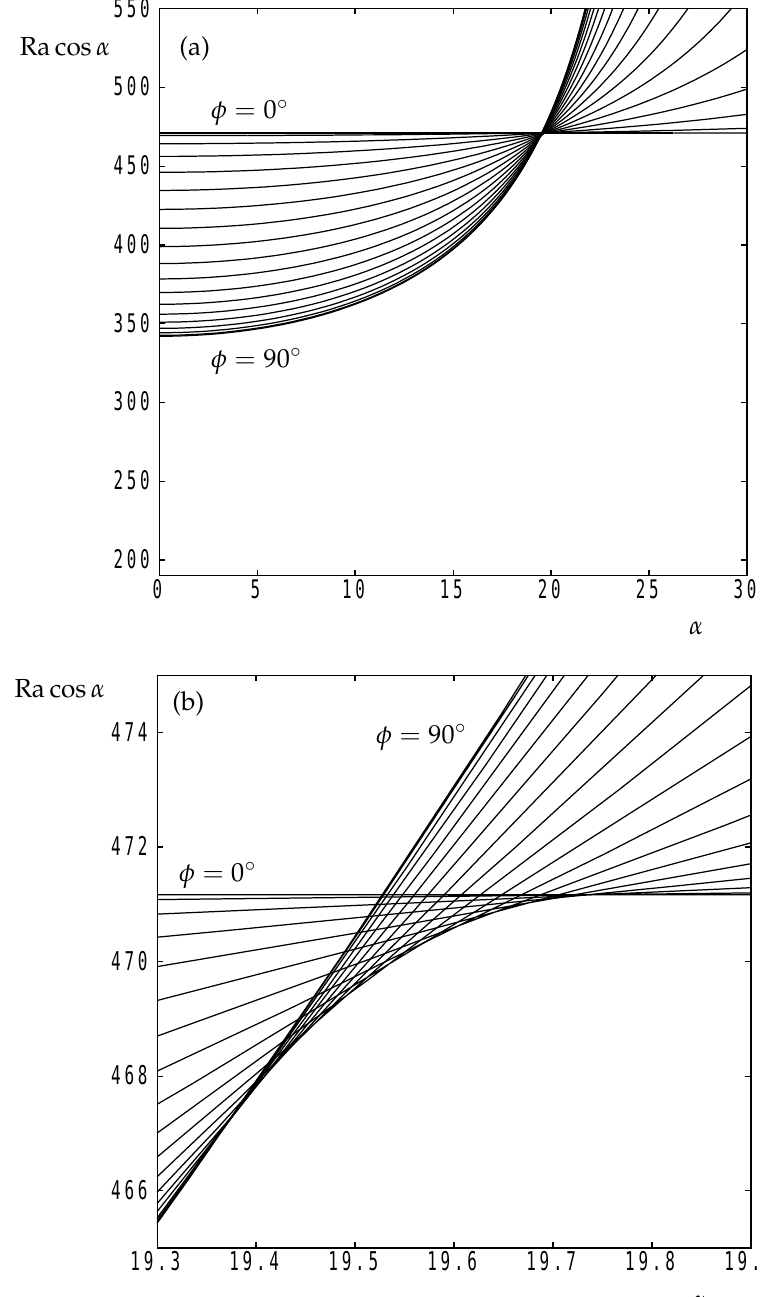
Figure 8. For ξ = 2. ( a ) the variation with α of the critical value of Ra cos α for the roll orientations, φ = 0 ◦ , 5 ◦ , 10 ◦ , . . . , 90 ◦ . ( b ) Showing a close-up view of the smooth transition between transverse and longitudinal rolls.